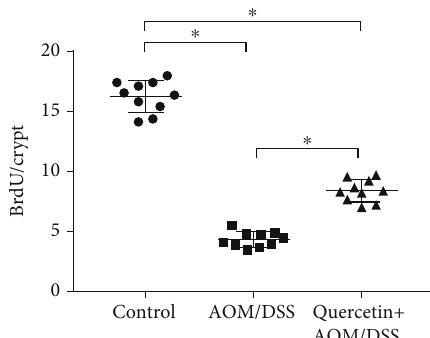
Figure 6: Quercetin restores cell proliferative activity in AOM/DSS- treated mice. Quanti fi cation of BrdU staining. BrdU cells per crypt were elevated; a total of 20 crypts per mouse; n = 10 per group. ∗ P < 0 : 05